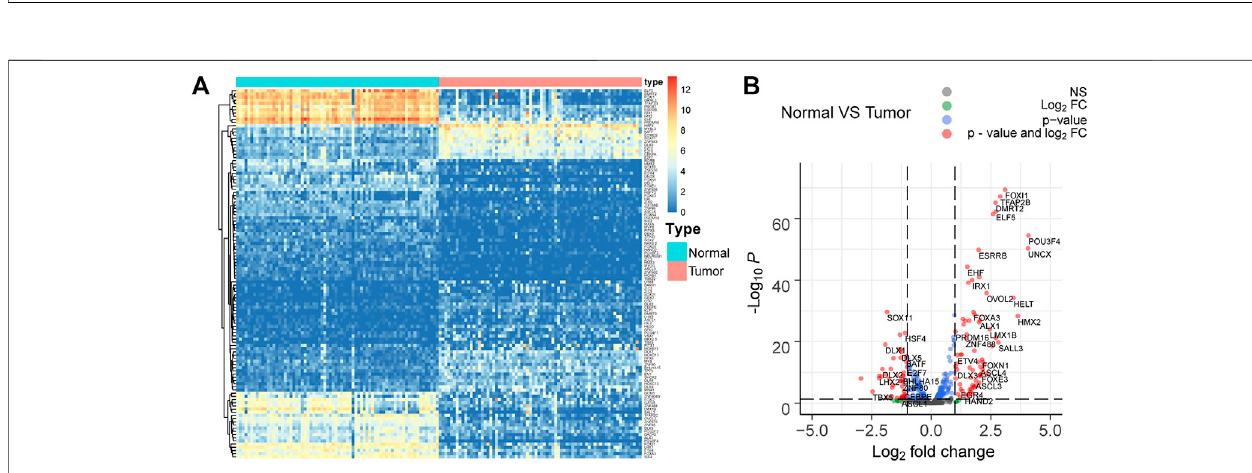
FIGURE 3 | Differentially expressed TFs in 72 paired tumor and adjacent normal tissues in the TCGA KIRC cohort. (A,B) 116 differentially expressed TFs with fold change > 1.3 and adjust p -value (padj) < 0.05 are selected. Among them, 46 TFs are upregulated, while 70 TFs are downregulated in ccRCC.